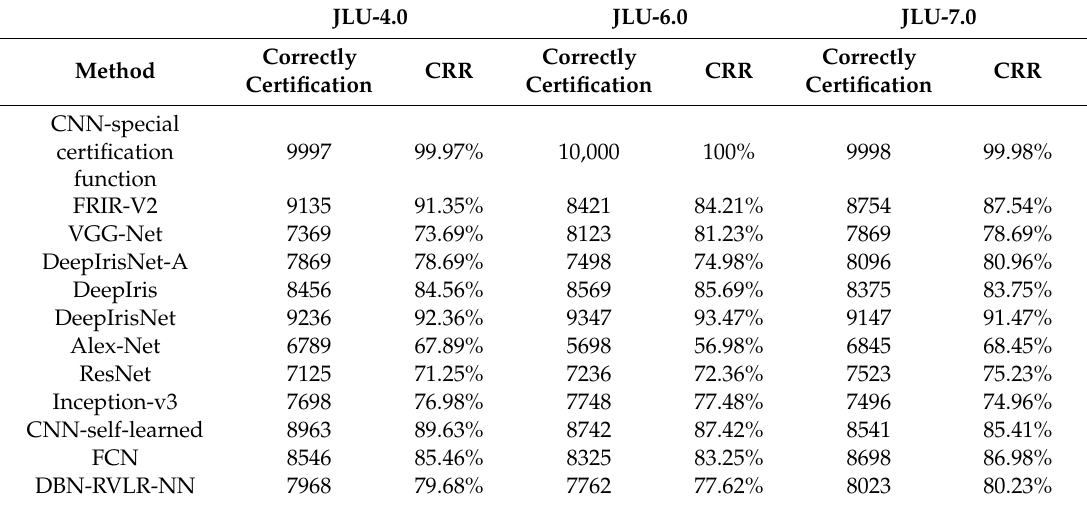
Table 5. The certification statuses of all 12 deep learning architecture